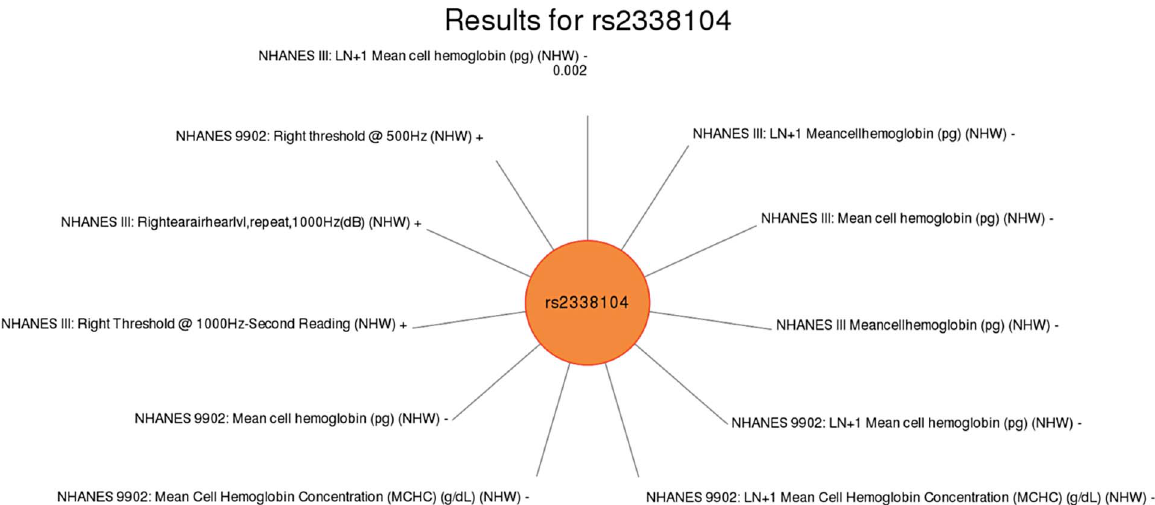
Fig. 6. Sun plot of (p , 0.01) results for KCTD10 rs2338104, coded allele G. This SNP was previously associated with HDL-C levels. Significant SNP-phenotype associations (p , 0.01) for this study are plotted clockwise with the smallest p-value result at the top. The length of the each line corresponds to the –log(p-value) of each result, with the longest line representing the most significant result for this SNP, meeting our PheWAS replication criteria for inclusion. Study, transformed (LN + 1) or untransformed (none) phenotype description, self-reported race-ethnicity, and direction of effect are listed for each association. This SNP was associated with mean cell hemoglobin levels, as well as right ear hearing levels in non- Hispanic whites (NHW).